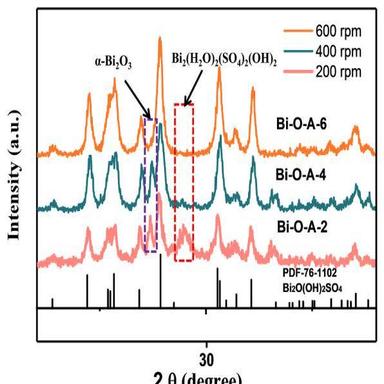
XRD patterns of the Bi–O-A sample by ball milling at different running speeds.